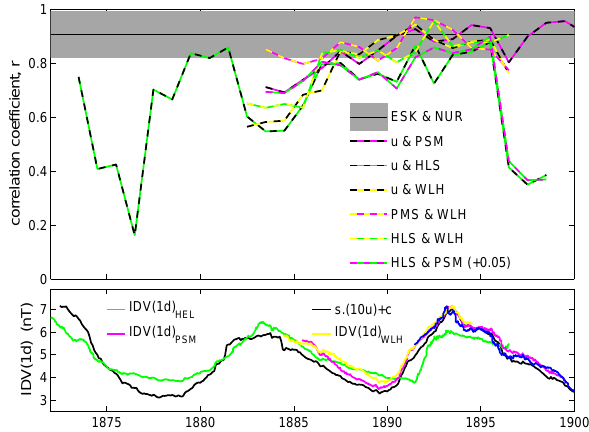
Fig. 16. (Top) Correlation coefficients, r , in 3yr windows of monthly data: (black and green dashed line) u and IDV(1d) HLS ; (black and mauve) u and IDV(1d) PSM ; (black and yellow) u and IDV(1d) WLH ; (mauve and yellow) IDV(1d) PSM and IDV(1d) WLH ; (green and yellow) IDV(1d) HLS and IDV(1d) WLH ; (green and mauve) IDV(1d) PSM and IDV(1d) HLS . The last line has been shifted up by 0.05 (approximately a line width) to avoid it sitting on top of other lines. The black horizontal line is the mean < r EN > for the modern data shown in Fig. 15, r EN being the correlation coefficient between IDV(1d) ESK and IDV(1d) NUR in 3yr windows between 1981 and 2008, and is surrounded by a grey band 2 σ EN wide, where σ EN is the standard deviation of the r EN values. (Bot- tom) 36-point (3yr) running means over the same interval of (green) IDV(1d) HLS ; (mauve) IDV(1d) PSM ; (yellow) IDV(1d) WLH ; (blue) IDV(1d) NGK ; and (black) the scaled u index, s · ( 10 u) + c , where s and c are given by the regression shown in Fig. 12. Note that all IDV(1d) values used or shown here are as derived from published station H values with no